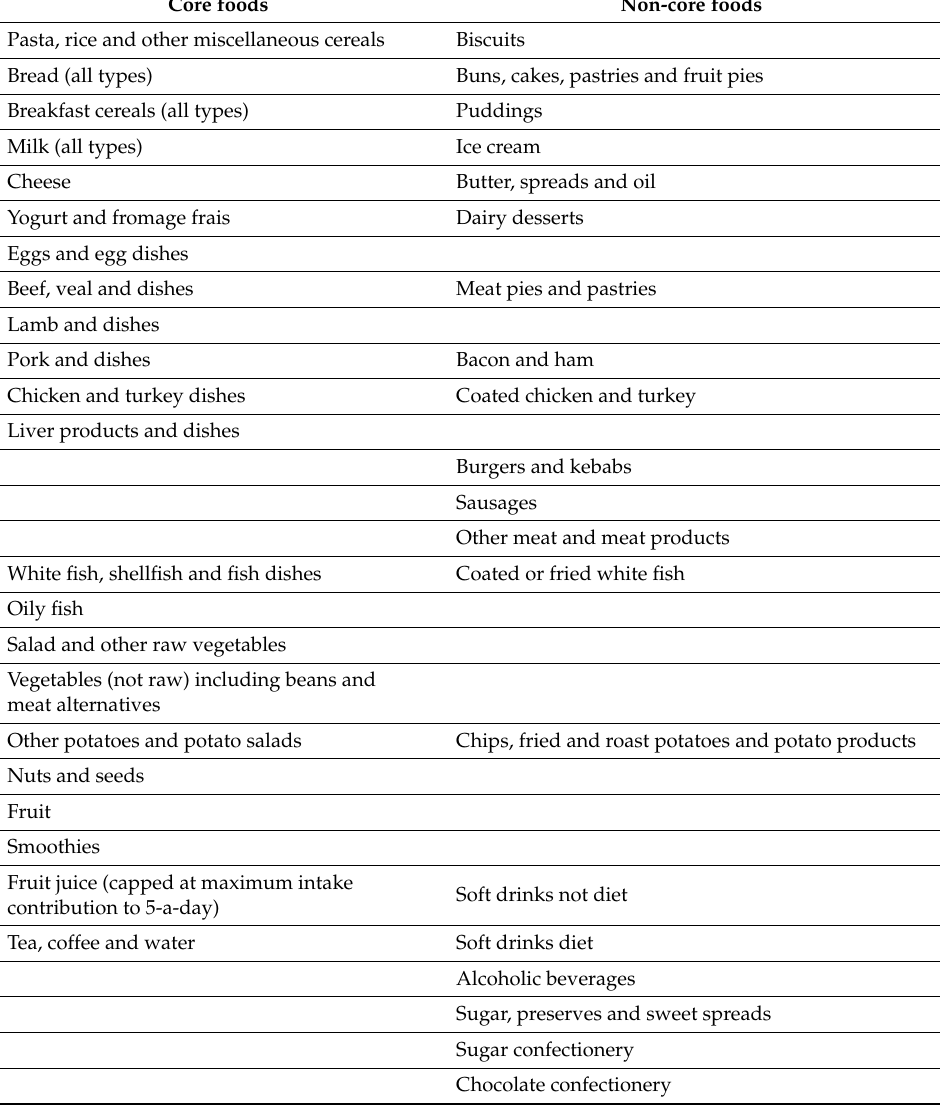
Table 1. National Diet and Nutrition Survey (NDNS) Rolling Programme (RP) food groups defined as core and